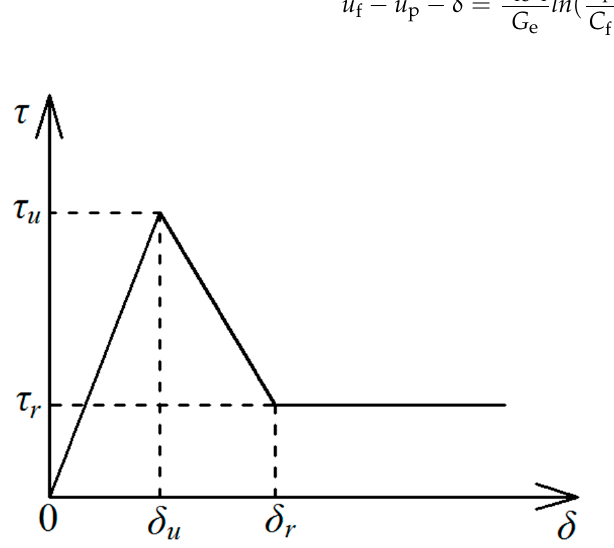
Figure 5. The trilinear bond-slip curve.